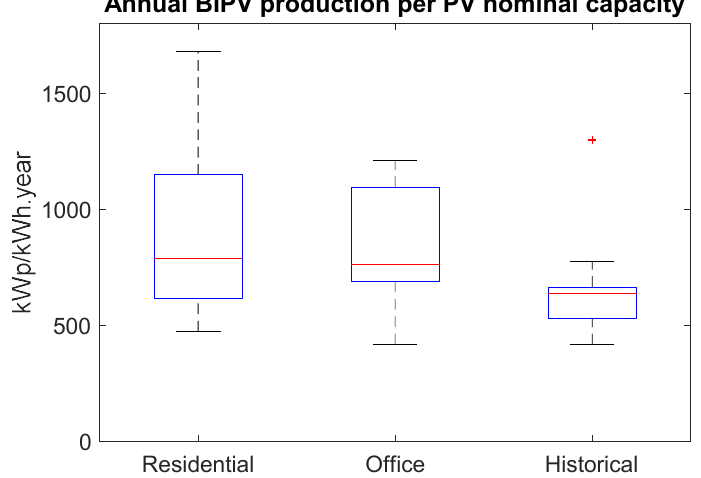
Figure 4. Annual BIPV production per photovoltaic (PV) nominal capacity installed for three types of buildings.